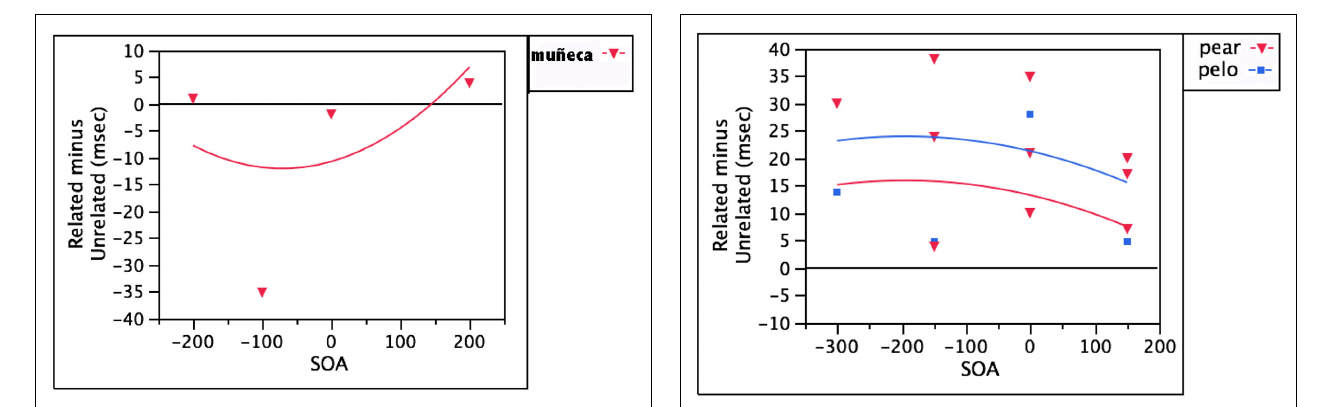
FIGURE 6 | Distractors that are phonologically related to the target’s translation yield interference whether they’re in the target (pear) or non-target (pelo)